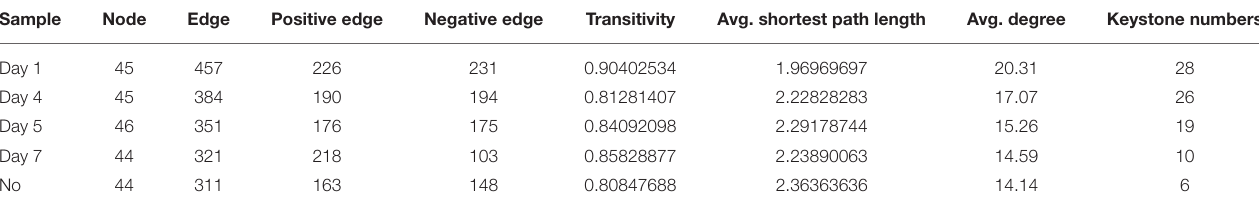
TABLE 1 | Attribute table of five co-occurrence networks.